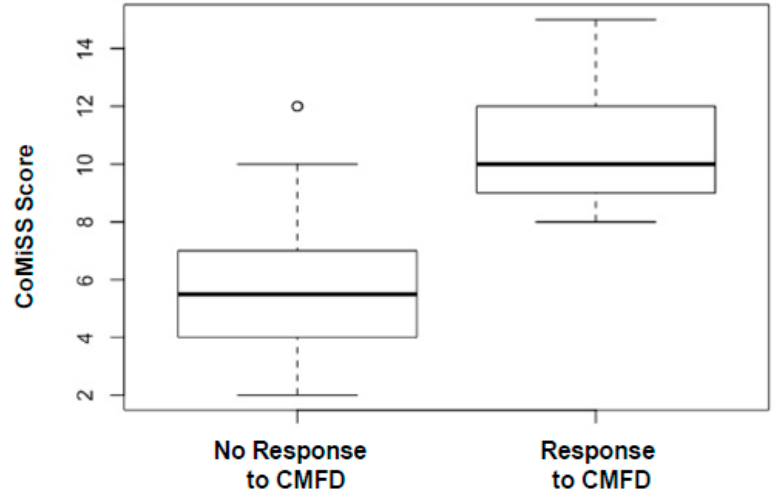
Figure 4. Box plot distribution of CoMiSS TM at baseline comparing infants who responded and did not respond to CMFD.